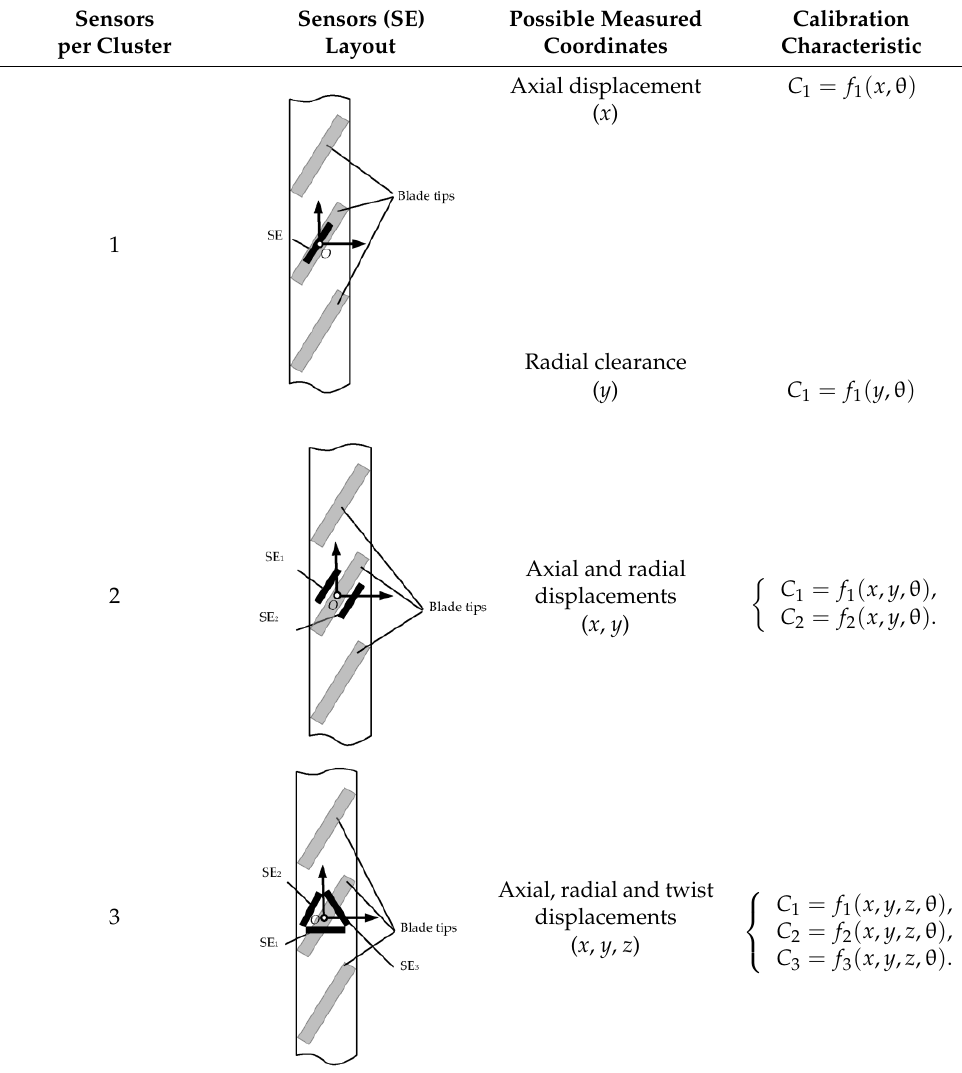
Table 1. Methods for the discrete surfaces (blade tips) monitoring on the base of concentrated clusters of SCECS.